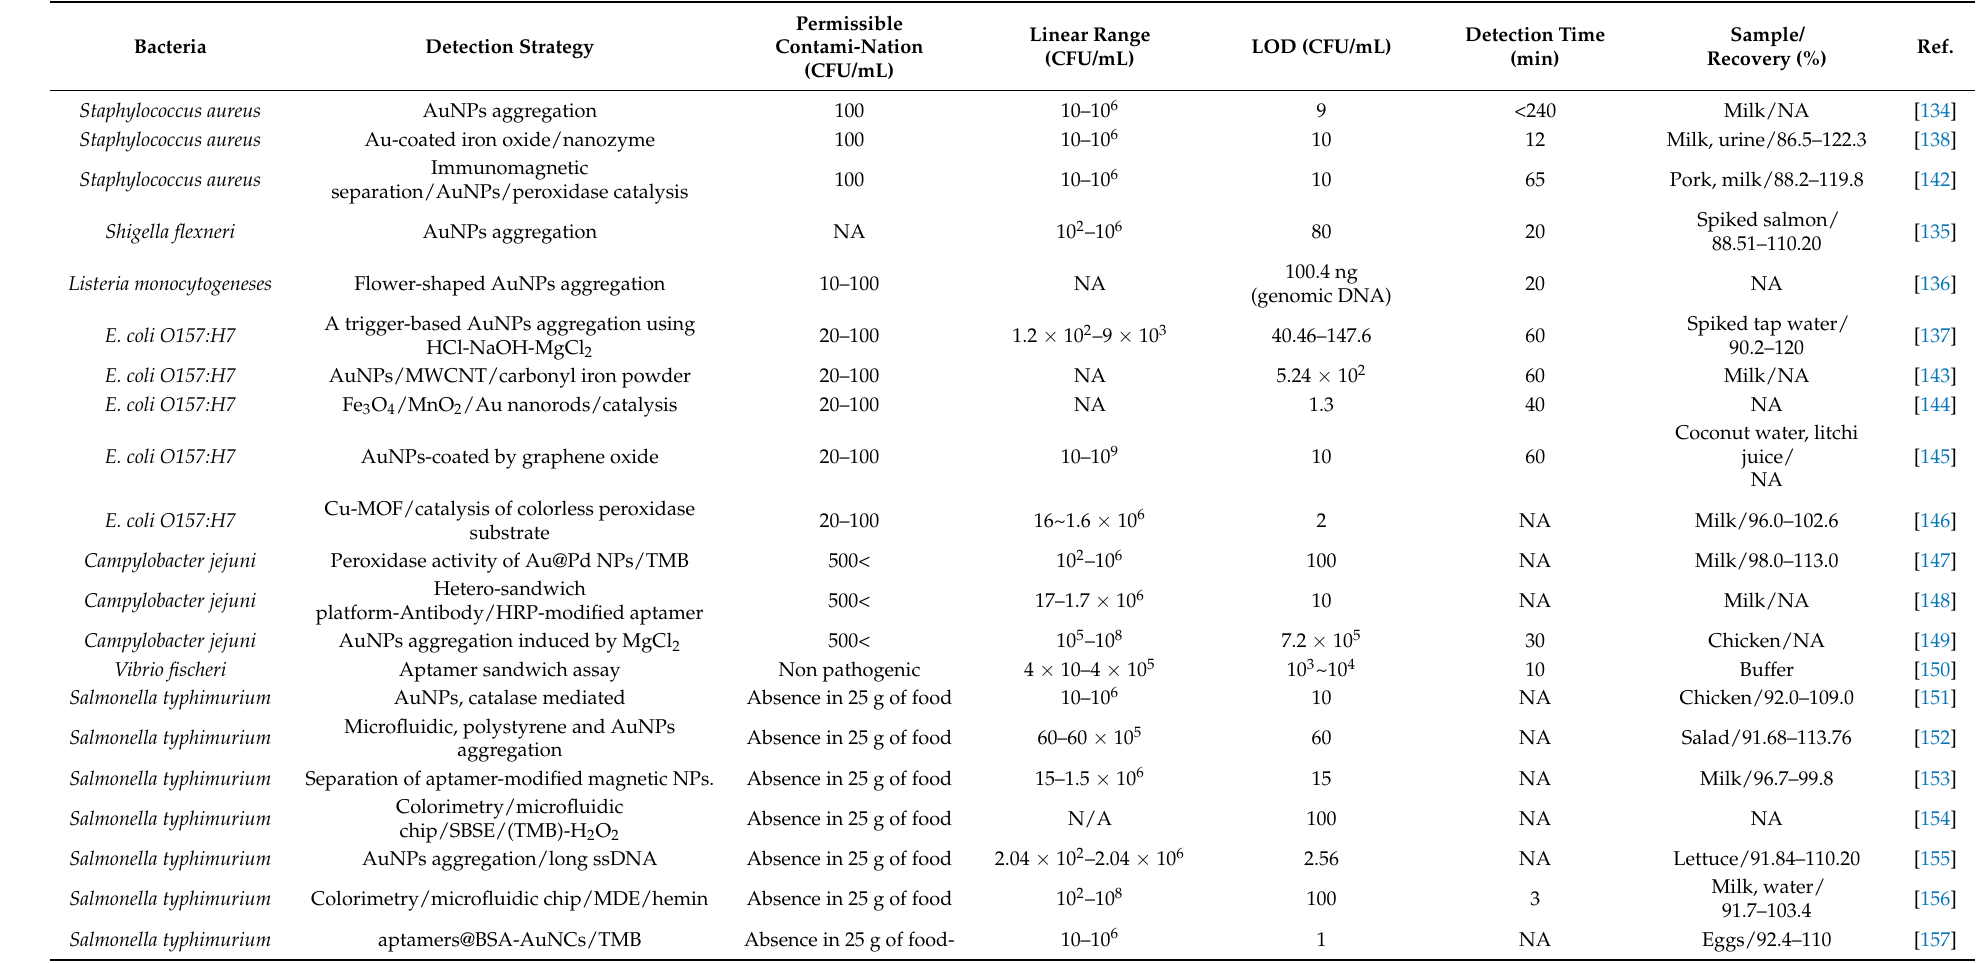
Table 5. Representative examples of the colorimetric assay for detection of bacterial pathogens and maximal permissible contamination values according to European Union regulations. NA—not